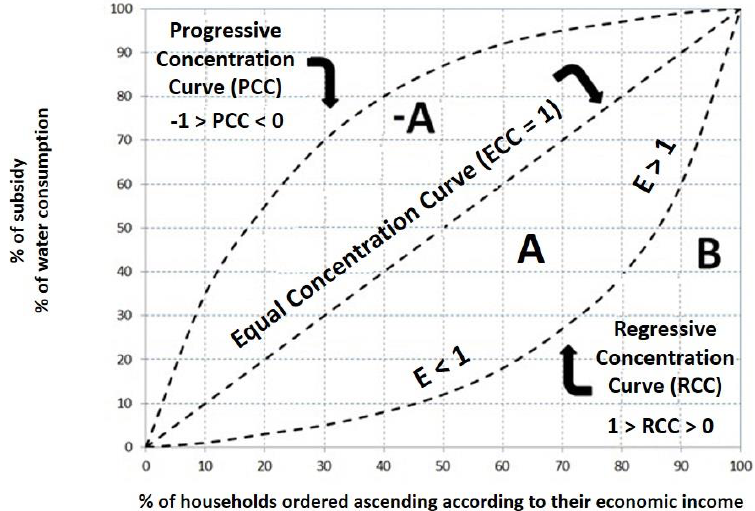
Figure 1. Concentration curve (CC) and indicator of concentration (IC). Source: Own Development, 2016.